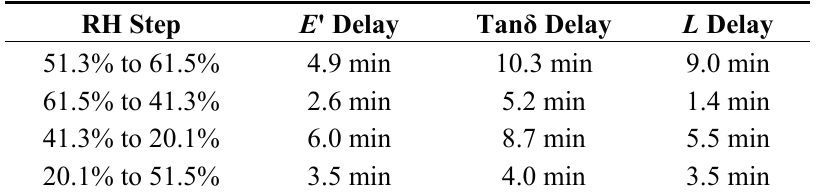
Table 3. Delay (min) between RH-stabilization and inflexion of the E ', Tan δ and L curves during RH-steps of Figure 9.